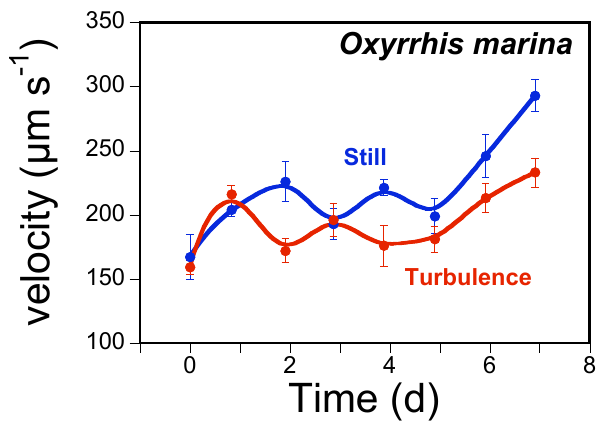
Fig. 1. Swimming velocity of four species of dinoflagellates over time in containers subjected to turbulence (red) or left still (blue). Fig. 2. Swimming velocity of Oxyrrhis marina over time in con- tainers subjected to turbulence (red) or left still (blue).